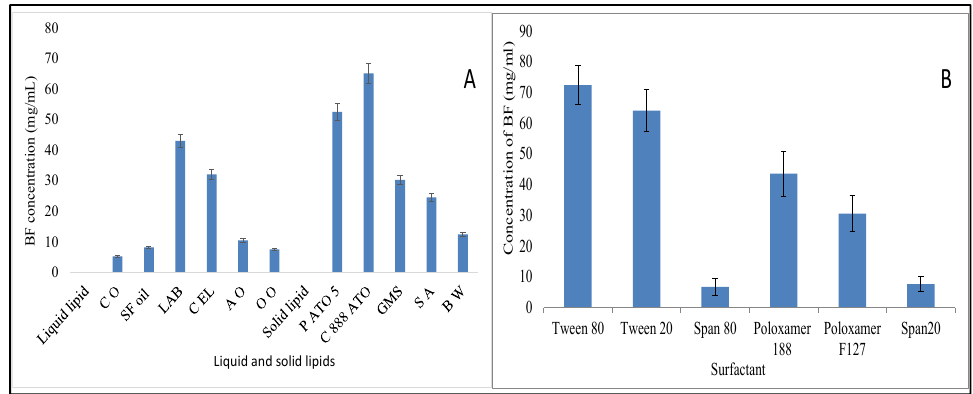
Figure 1. ( A ): Solubility study result of BF in different liquid and solid lipids. Each study performed in triplicate and data shown as mean ± SD. ( B ): Solubility study result of BF in different surfactants. Each study performed in triplicate and data shown as mean ± SD.